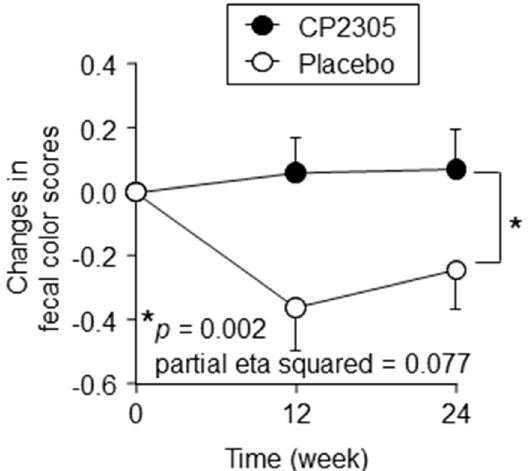
Figure 3. E ff ects of CP2305 on the time-dependent changes in fecal color. Fecal color tone was assessed using the Bristol Stool Scale. Black circles represent data from participants receiving CP2305 and white circles placebo. Data are presented as the mean ± SEM. Data were analyzed by repeated-measures ANOVA between the groups without multiple comparison correction. p and partial eta squared value are shown in the panel. Asterisks indicate overall significance between the groups across time points. * p <